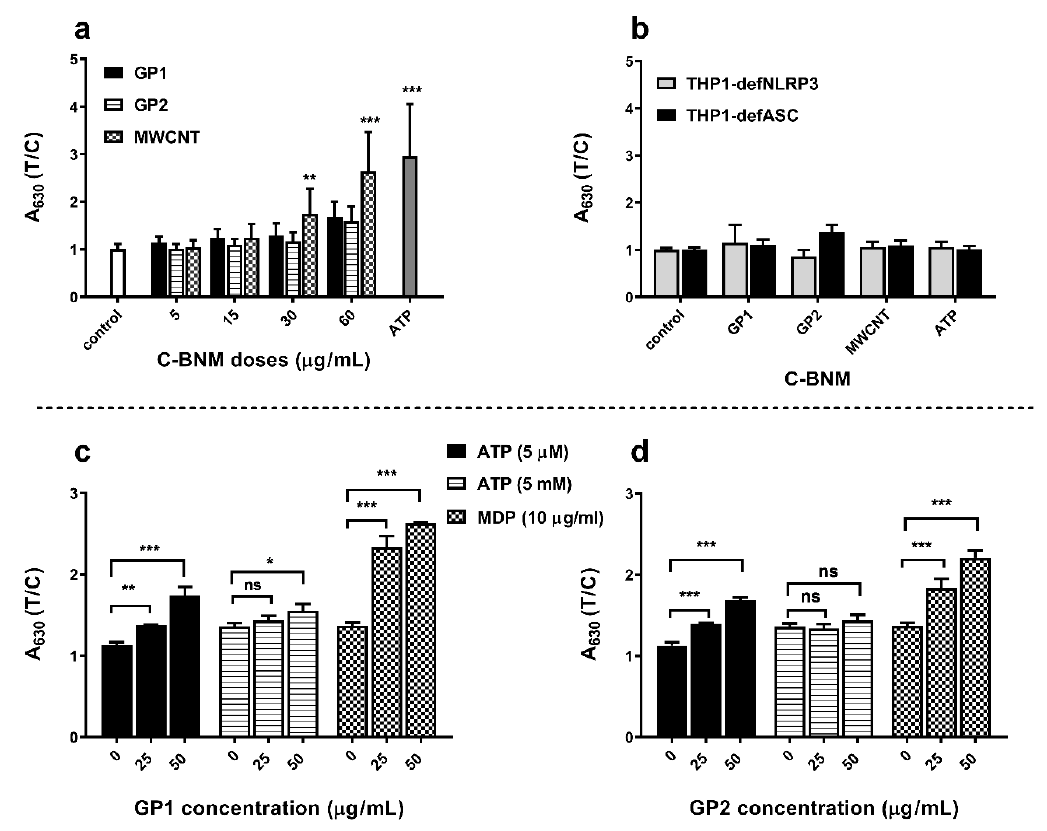
Figure 6. E ff ect of C-BNM on activation of inflammasome NLRP3 after 24 h exposure: ( a ) NLRP3 activation in THP1 null cells was measured as conversion of proIL-1 β to IL-1 β , which was detected using HEK-Blue ™ IL-1 β cells. Data were normalised to the control (untreated THP1-null cells). ATP was used as positive standard of NLRP3 induction. The symbols ** p < 0.01; *** p < 0.001 highlight the statistical significance as compared to the corresponding control; ( b ) Activation of NLRP3 in deficient cells THP1-defNLRP3 and THP1-defASC, which were treated the same way as THP1-null cells; ( c , d ) activation of NLRP3 in THP-1 null macrophages by GP in presence of MDP and ATP: ATP (5 mM; 5